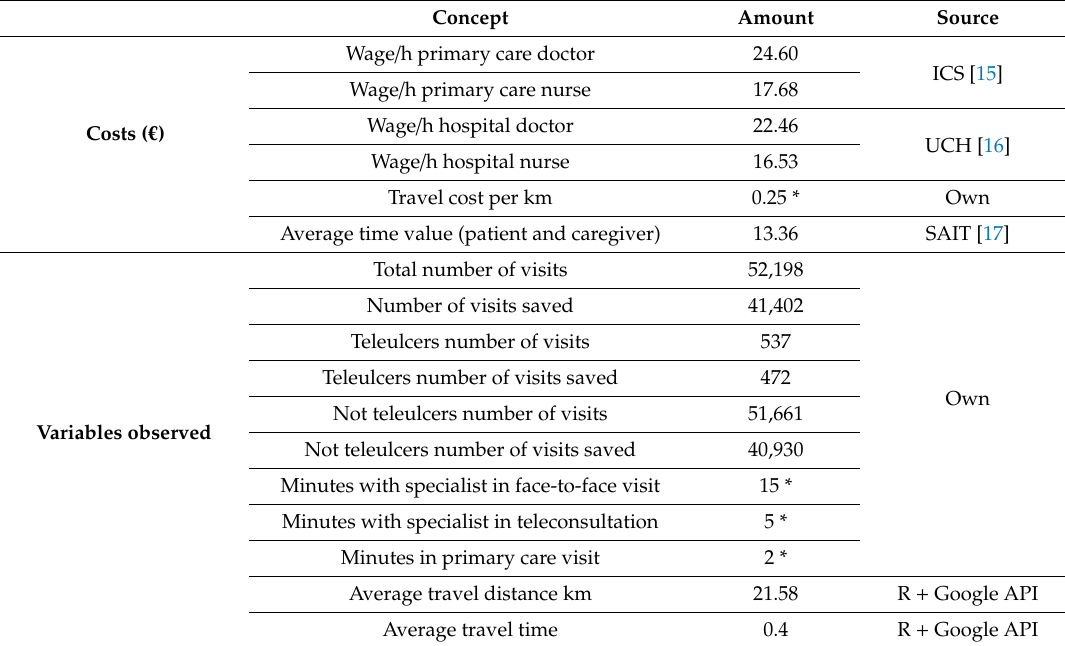
Table 3. Calculation